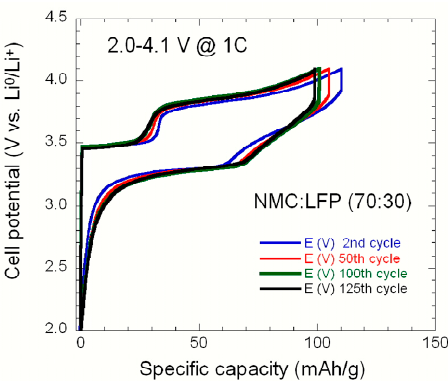
Figure 9. Electrochemical performance of a Li coin cell with a NMC–LFP (70:30) blend positive electrode as a function cycle.